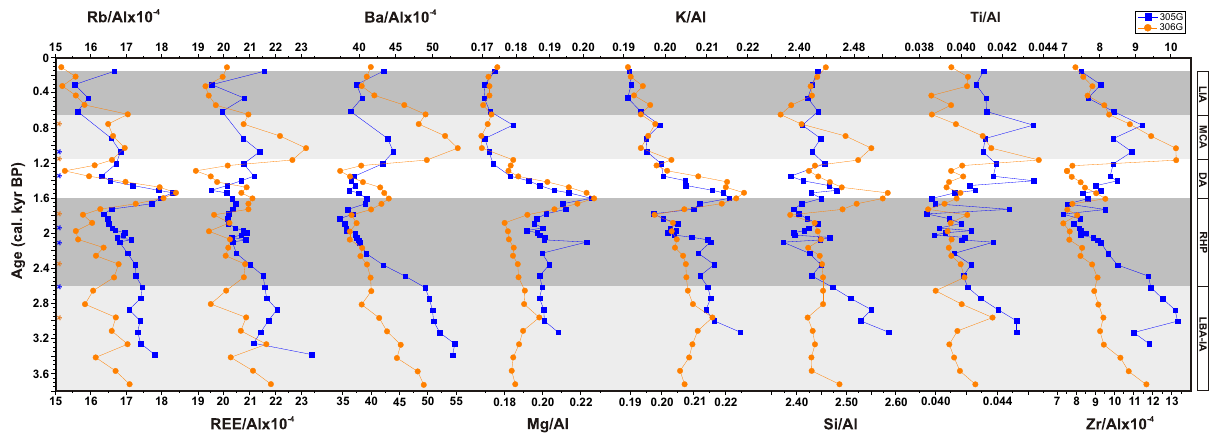
Fig. 5. Age-depth profile of detrital proxies (Rb/Al, REE/Al, Ba/Al and REE/Al × 10 − 4 ratios, Si/Al, Ti/Al, Mg/Al, and K/Al ratios) for cores 305G (blue squares) and 306G (orange circles). Light grey bars indicate dry periods (MCA: Medieval Climate Anomaly, DA: Dark Ages, LBA-IA: Late Bronze Age-Iron Age); dark grey bars indicate humid periods (LIA: Little Ice Age, RHP: Roman Humid Period). Asterisks indicate the AMS 14 C